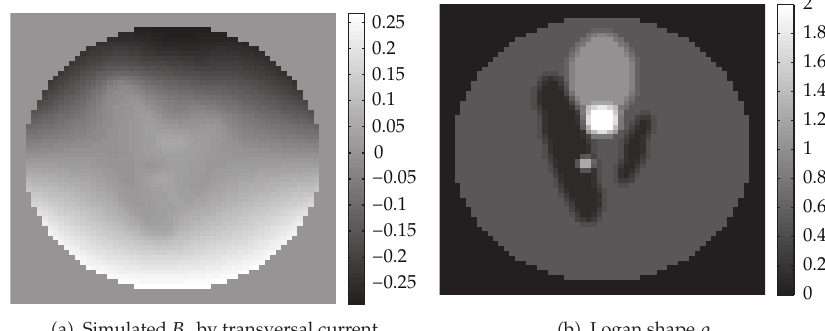
Figure 2: Simulated B z and ρ .